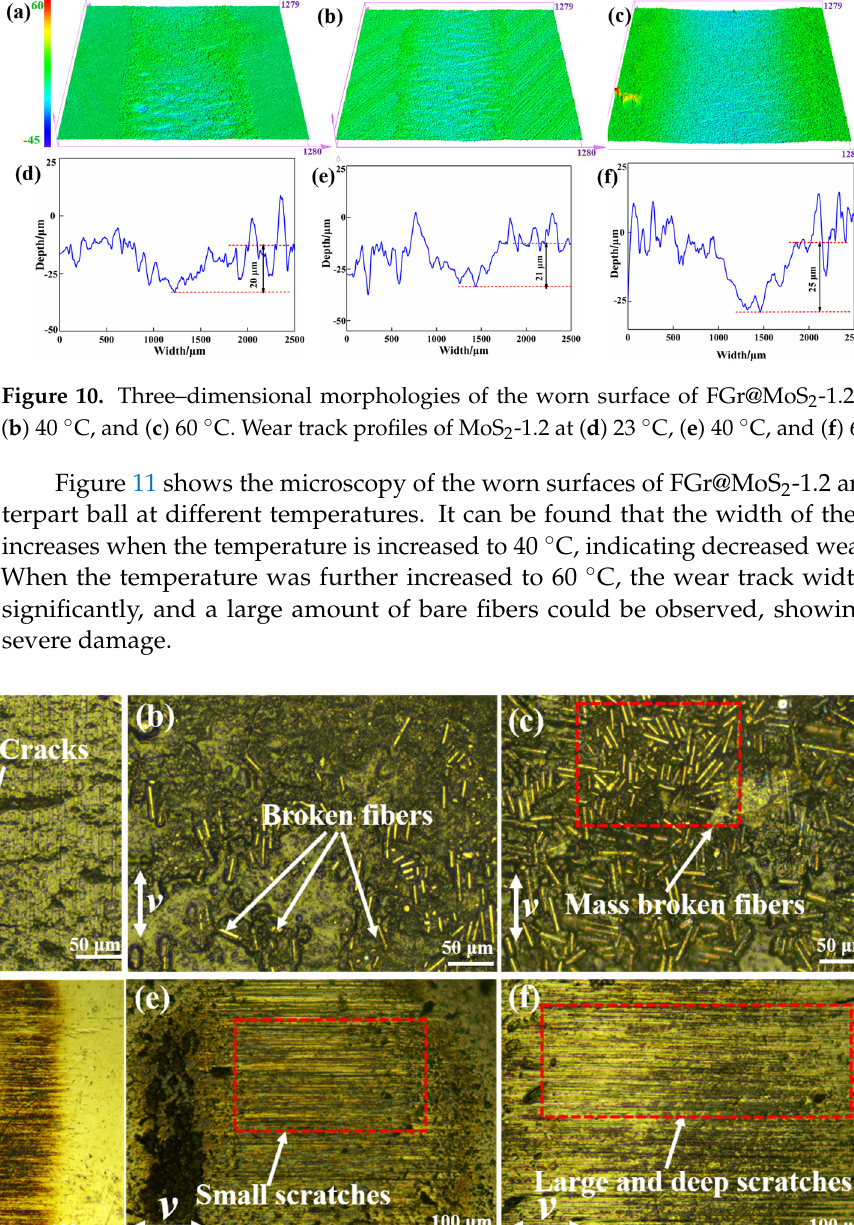
Figure 9. Tribological properties of FGr@MoS 2 -1.2 at different temperatures: ( a ) friction coefficient and ( b ) wear rate.